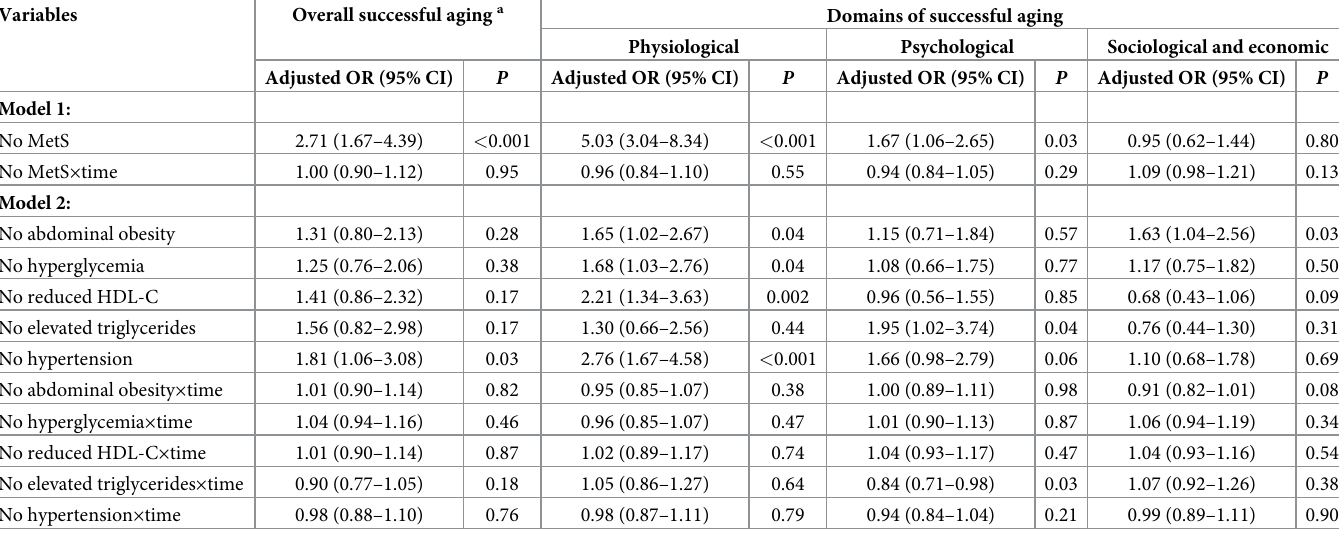
Table 2. The associations between MetS and successful aging over six years (n =